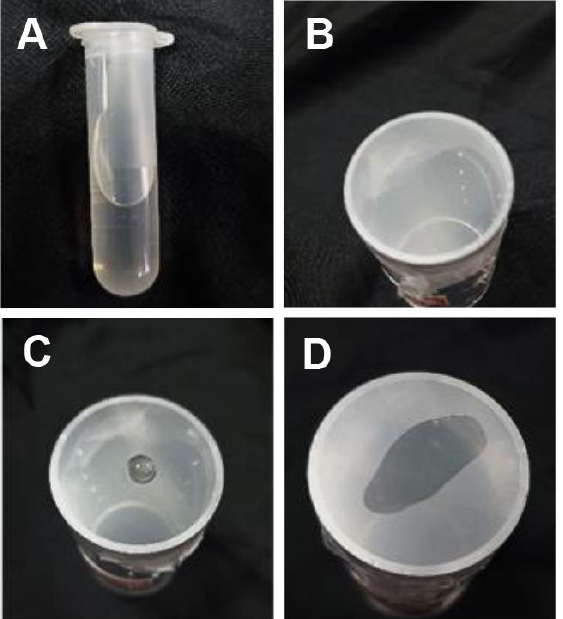
Figure 1. Schematic of artificial feeding installation. ( A ) The solution of BPH artificial diet; ( B ) arti- ficial feeding chamber (8 cm long and 4 cm in diameter) with one end covered by a well-stretched Paraffin membrane; ( C ) an artificial diet droplet on the center of Parafilm membrane; ( D ) the artificial diet droplet sandwiched between two layers of Parafilm membrane.